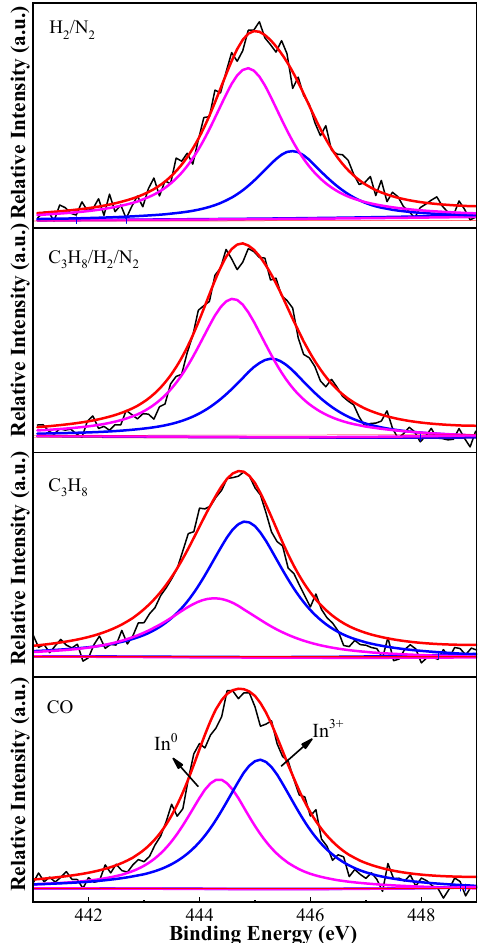
Figure 4. In3d 5 / 2 XPS spectra of a PtIn / MAZ catalytic system reduced with di ff erent atmospheres Figure 4. In3d 5/2 XPS spectra of a PtIn/MAZ catalytic system reduced with different atmospheres (reduction conditions: T = 600 ◦ C, t = 2.5 h). (reduction conditions: T = 600 º C, t = 2.5 h). Table 1. XPS results and Pt dispersion of a PtIn / MAZ catalytic system reduced with di ff erent Table 1. XPS results and Pt dispersion of a PtIn/MAZ catalytic system reduced with different